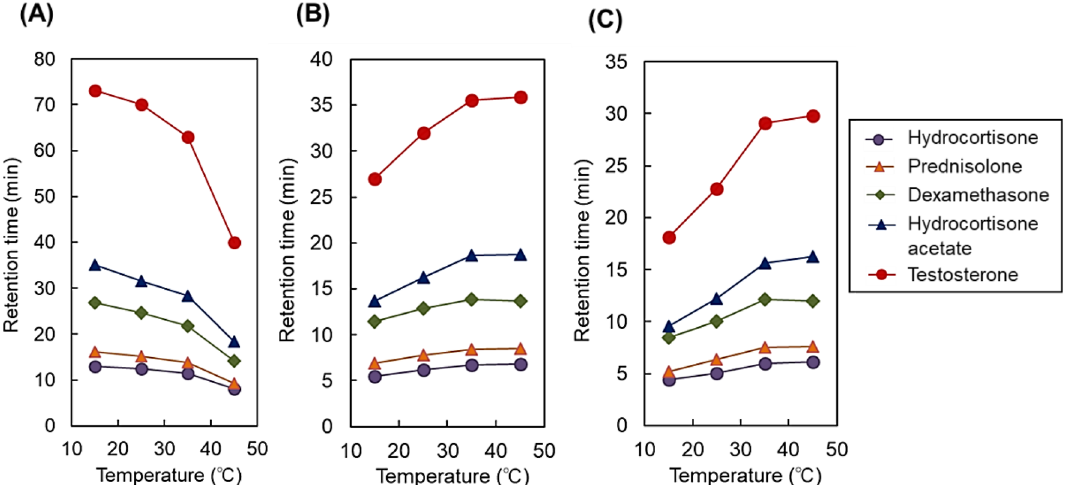
Figure 3. Retention time of hydrophobic steroids using P(NIPAAm- co -BMA) hydrogel-modified bead columns with ( A ) 7-nm pore-diameter beads, ( B ) 12-nm pore-diameter beads, and ( C ) 30-nm pore-diameter beads as base